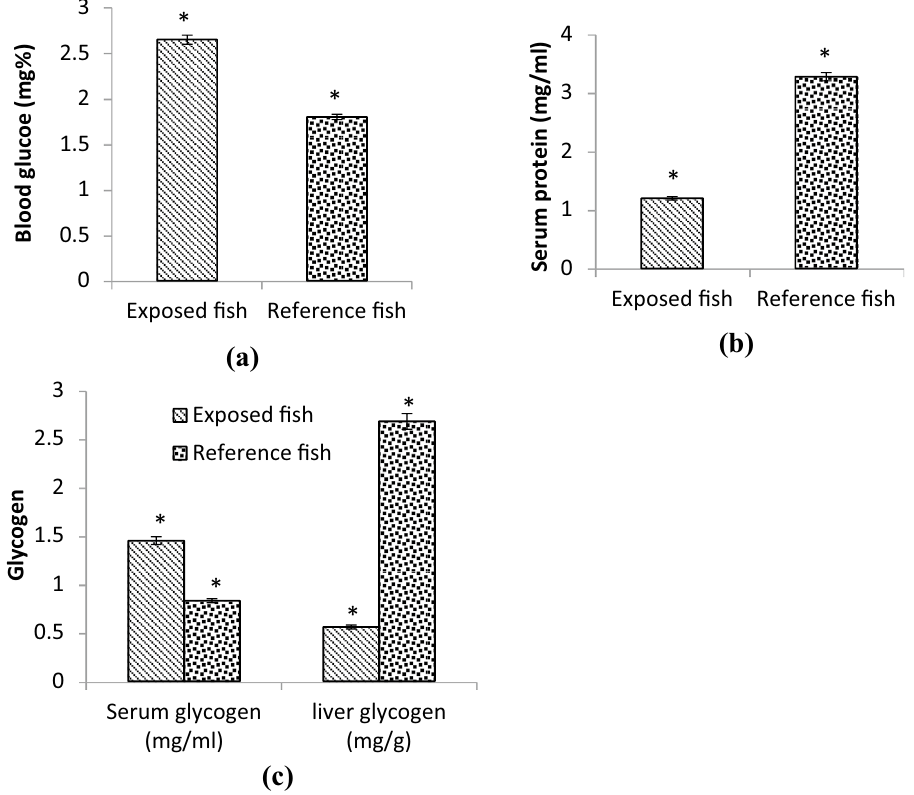
Figure 2. Illustrates the ( a ) blood glucose, ( b ) serum protein, ( c ) glycogen levels in serum and liver of exposed and reference Bagarius sp. Significance was checked at p < 0.05.